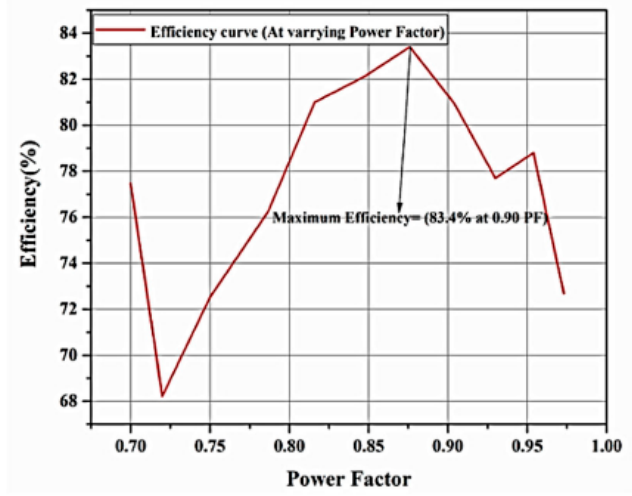
Figure 18. Efficiency vs. power factor.